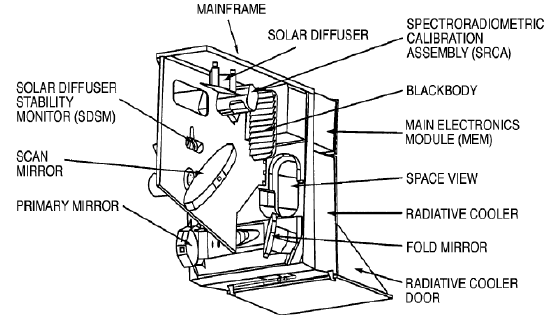
Figure 9. MODIS scan cavity and on-board calibrators